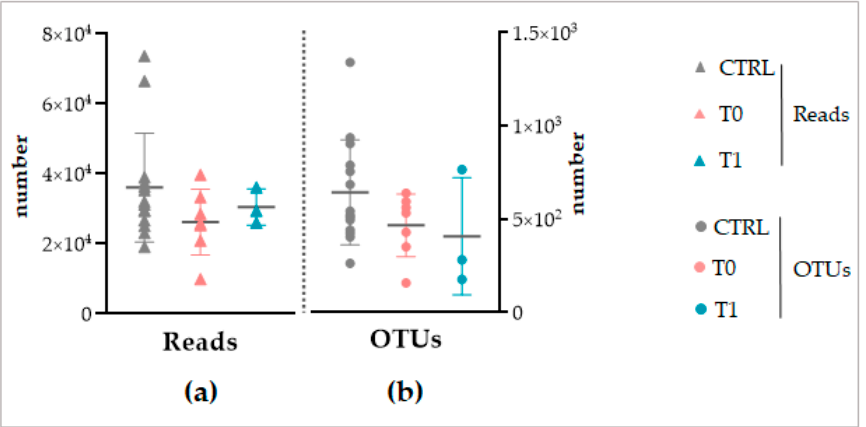
Figure 3. The sequencing output from the NGS Illumina MiSeq of 16S and ITS amplicons libraries. ( a ) The number of reads obtained. ( b ) The number of matched OTUs. The grey horizontal line highlights the average value.